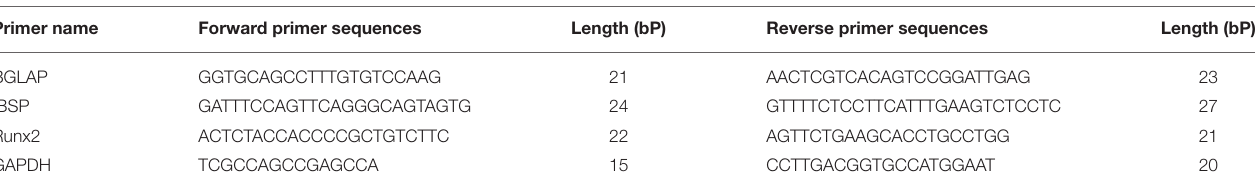
TABLE 2 | The characteristic of primers used for real-time PCR assay.